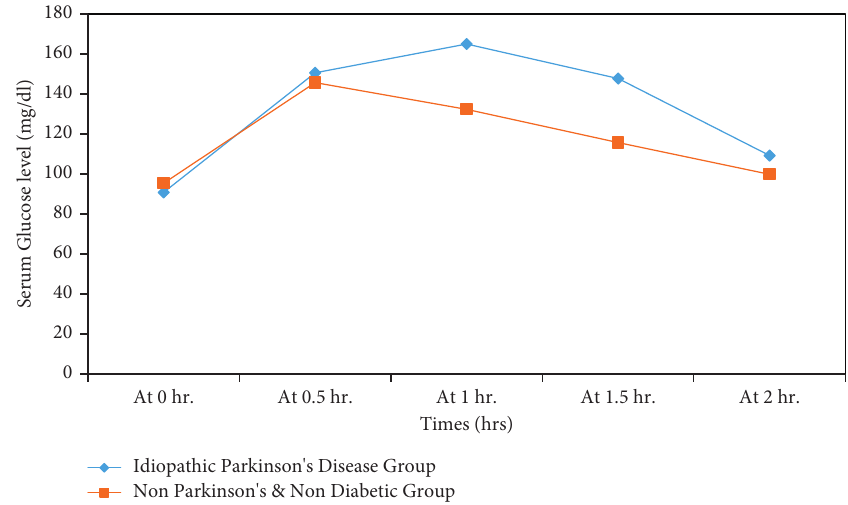
Figure 3: Blood glucose kinetics during the 75g oral glucose tolerance test (OGTT).